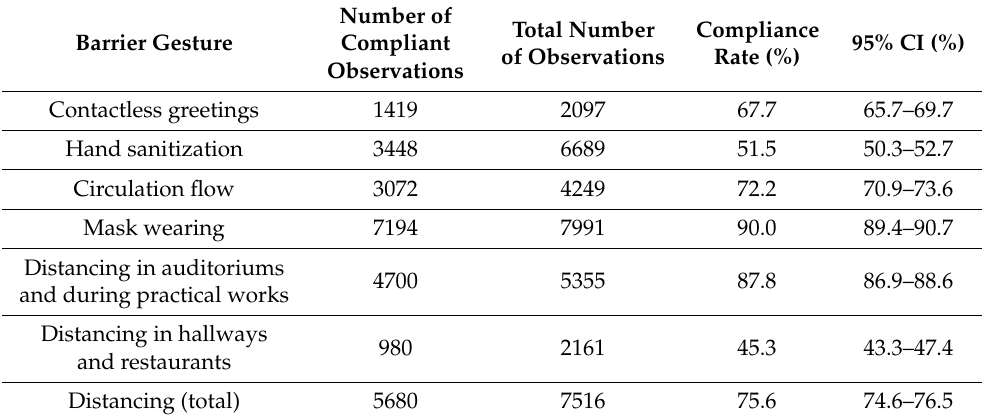
Table 2. Observed compliance rate of barrier gestures from week 11 to week 25,